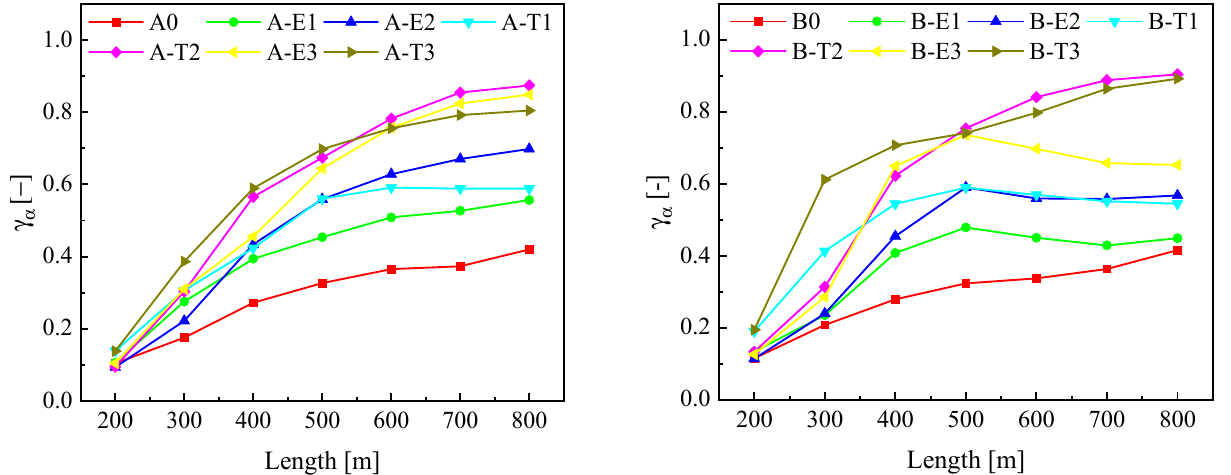
Figure 8. The NH 3 concentration uniformity index.